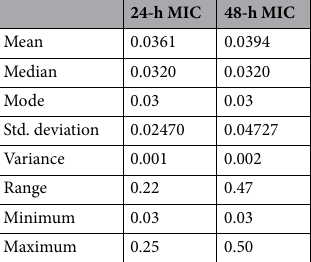
Table 4. Posaconazole 24-h and 48-h MIC statistics for 102 isolates of C. albicans.